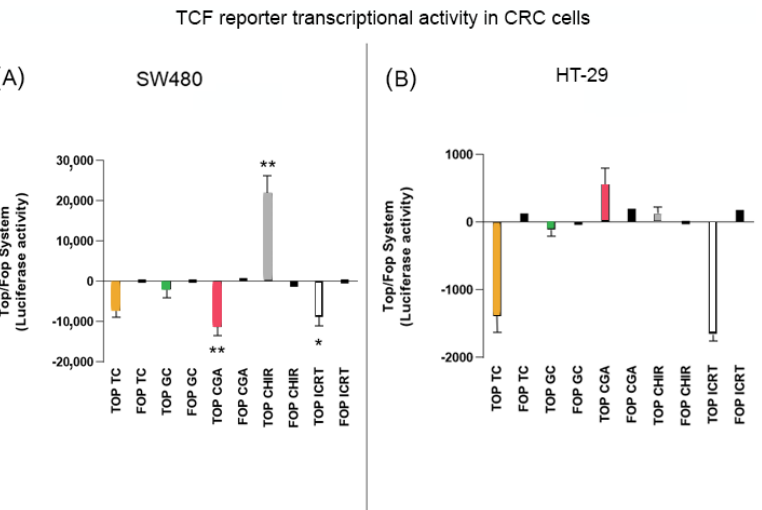
Figure 5. The inhibition of TCF promotor activation of the Wnt pathway plasmid reporter system in SW480 ( A ) and HT-29 ( B ) cell lines. CHIR 99021 was used as a pathway inductor and iCRT14 as an inhibitor. Treatment exposure was 24 h after transfection. Values are expressed as the mean ± SEM of three independent experiments. Two-way ANOVA, difference to non-treated cells, * p ≤ 0.05 and ** p ≤ 0.01